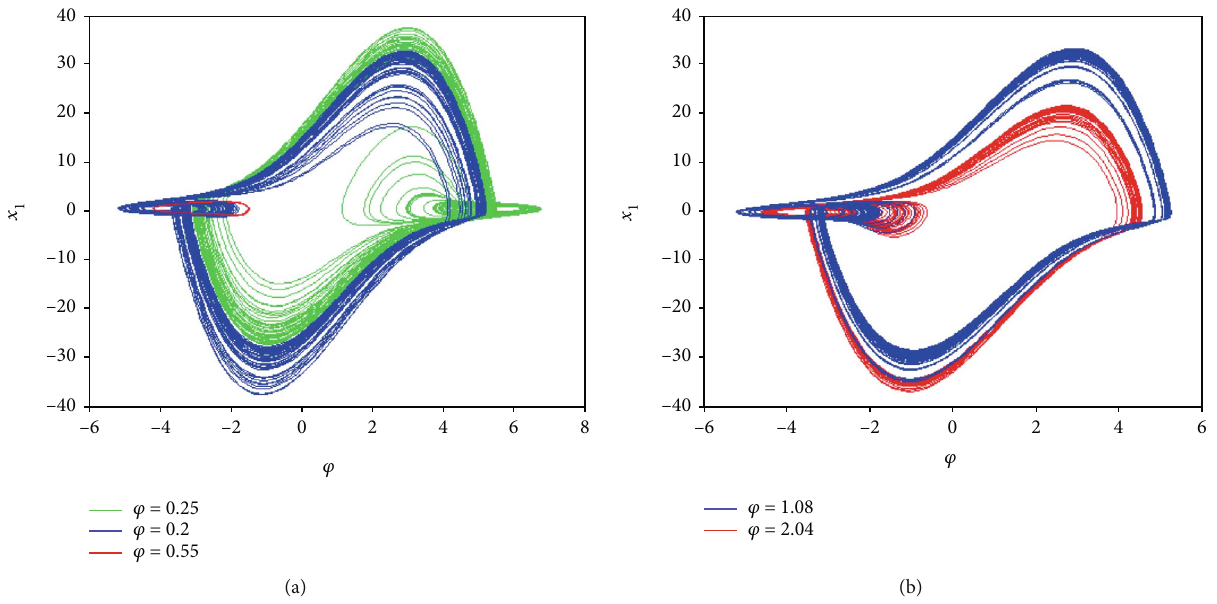
Figure 8: Multistability of the memristor-based CNN: (a) heterogeneous multistability and (b) homogenous multistability.